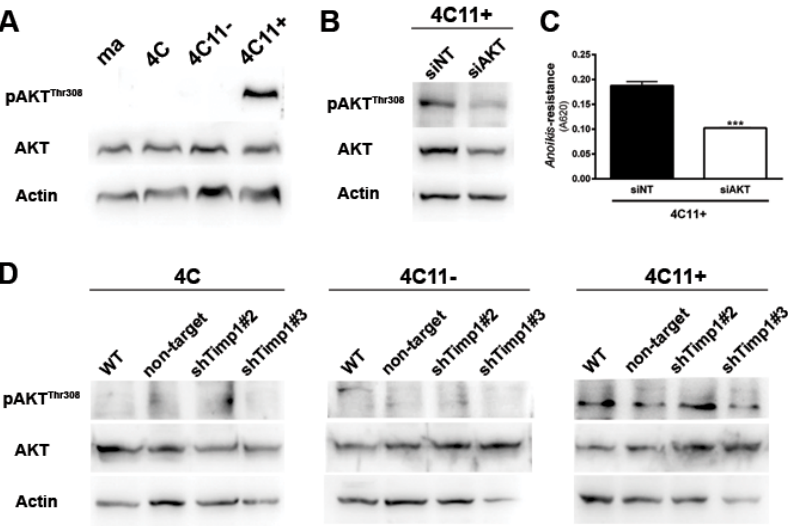
Figure 3. AKT contributes to anoikis resistance in metastatic melanoma cell lines independently of Timp1. ( A ) AKT activation was evaluated in melan-a (ma), 4C, 4C11 − and 4C11+ cells lines by Western blotting. As loading control, total AKT and β -actin were used. ( B ) AKT activation was analyzed by Western blotting in the 4C11+ cell line, treated with a non-target siRNA (siNT) and a siRNA specific to AKT (siAKT). Total AKT and β -actin were used as loading controls. ( C ) Anoikis resistance was determined after maintaining control (siNT) and siAKT 4C11+ cells in suspension for 96 h. ( D ) AKT activation was analyzed by Western blotting in 4C, 4C11 − , and 4C11+ cell lines and their Timp1 silenced clones. Total AKT and β -actin (Actin) were used as loading controls. WT: non-treated cells; non-target: control non-target shRNA; shTimp1#2: clone 2 silenced for Timp1; shTimp1#3: clone 3 silenced for Timp1. *** p < 0.001.